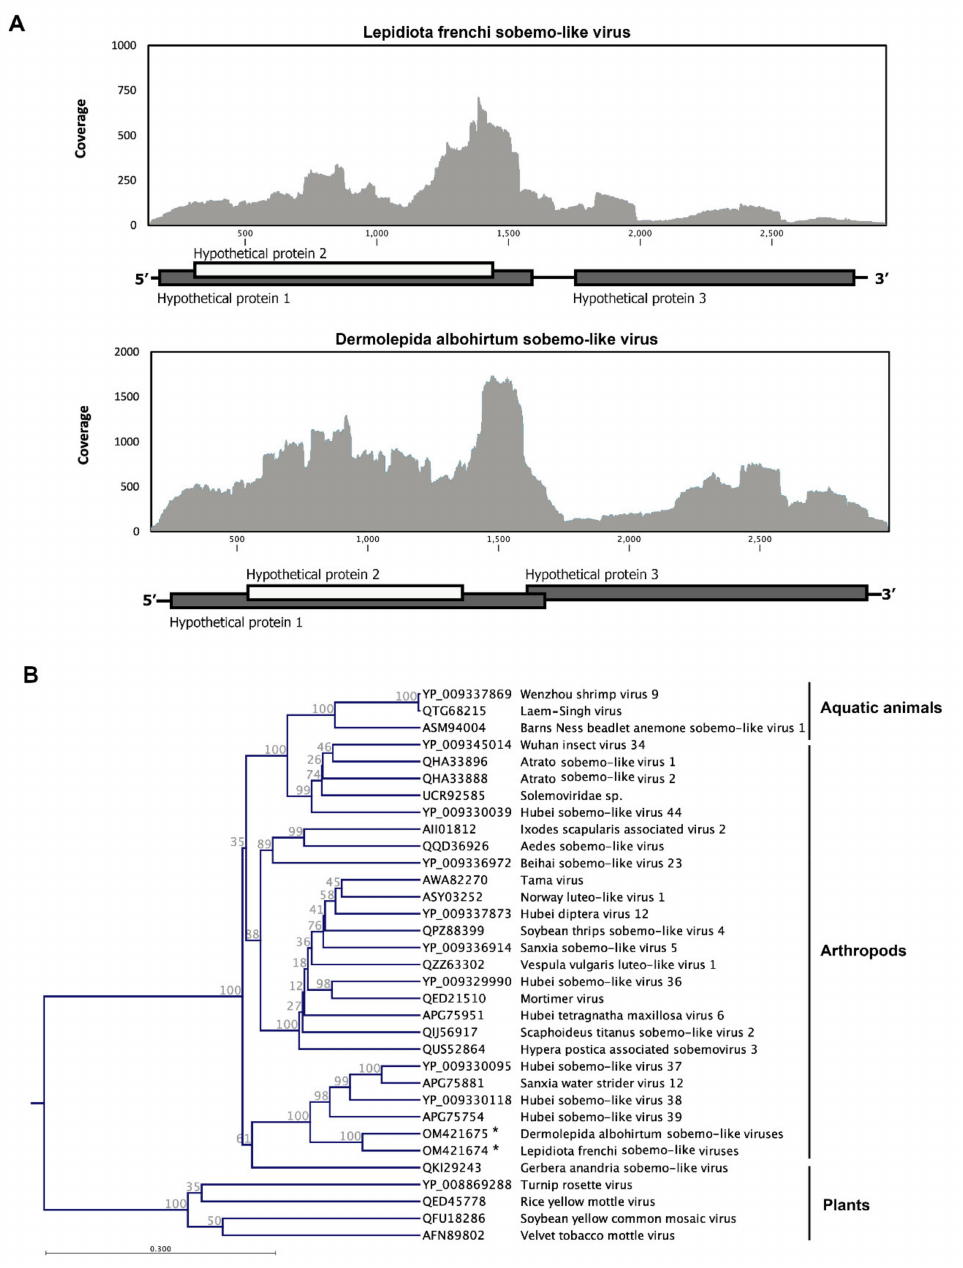
Figure 5. Schematic of the genome organization and coverage of two newly identified sobemo-like viruses from Australian canegrubs. The DaSV genome was built by 11,244 assembled reads that showed an average coverage of 283.01 × while the LfSV genome was built by only 2893 assembled reads with an average coverage of 96.86 × . RNA-Seq read density plotted along the viral genome. The Y -axis shows the number of reads mapped to a particular nucleotide of the virus genome at the X -axis ( A ). The maximum likelihood phylogeny of canegrubs sobemo-like viruses (DaSV and LfSV) and previously reported sobemoviruses based on deduced amino acid sequence of ORF3 (conserved RdRP domain). DaSV and LfSv were classified with other unassigned sobemo-like viruses that previously reported from insects and other arthropods. The plant sobemoviruses have been clustered in another clade. The identified virus in this study is shown with an asterisk ( B